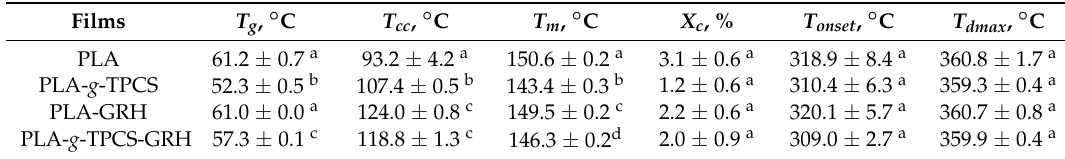
Figure 4. Thermogravimetric analysis (TGA) thermograms of the tested samples produced by twin-screw extrusion–cast-film extrusion. Table 6. T g , T cc , T m , and X c from the second heating cycle of differential scanning calorimetry (DSC), and T onset and T dmax from TGA.